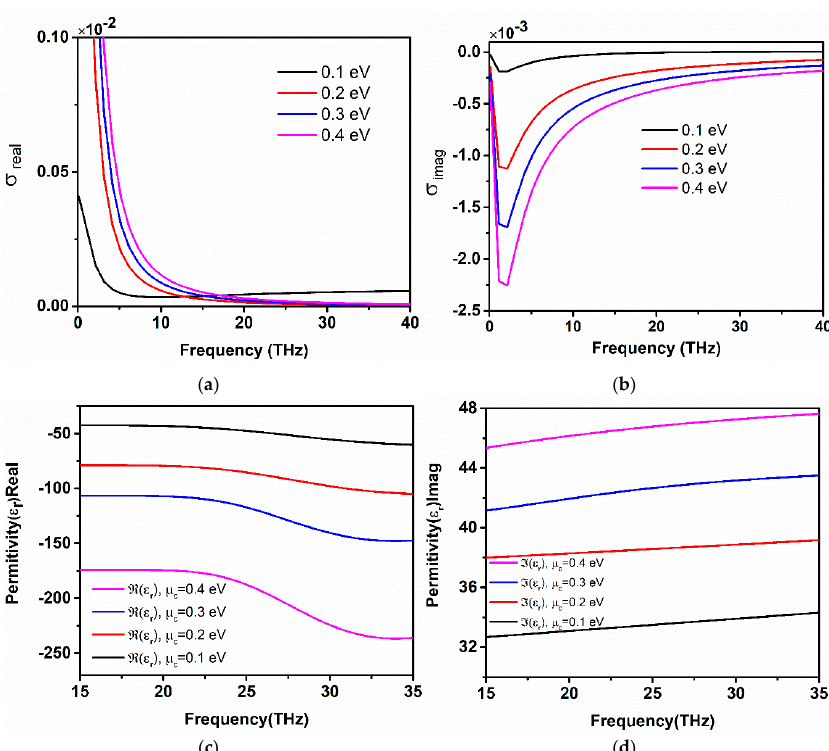
Figure 1. Complex graphene conductivity and permittivity with increasing chemical potential from 0.1 eV to 0.4 eV, ( a ) real part of graphene conductivity, ( b ) Imaginary part of graphene conductivity. ( c ) The real permittivity of multilayer graphene, and ( d ) Imaginary permittivity of multilayer graphene.